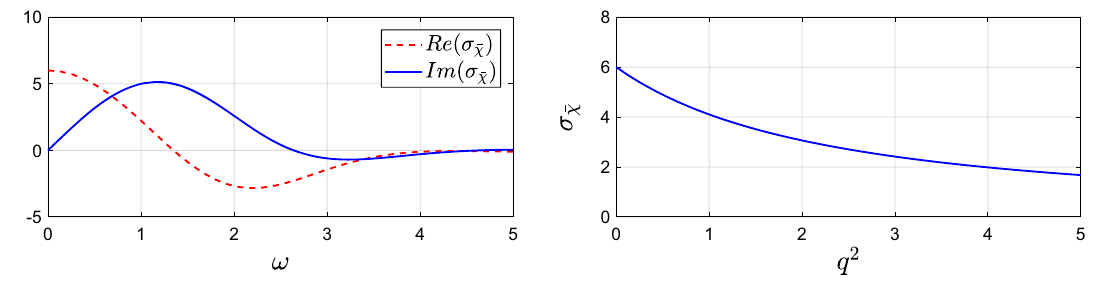
Fig. 2 The generalised CME/CSE conductivity σ ¯ χ as a function of ω and q 2